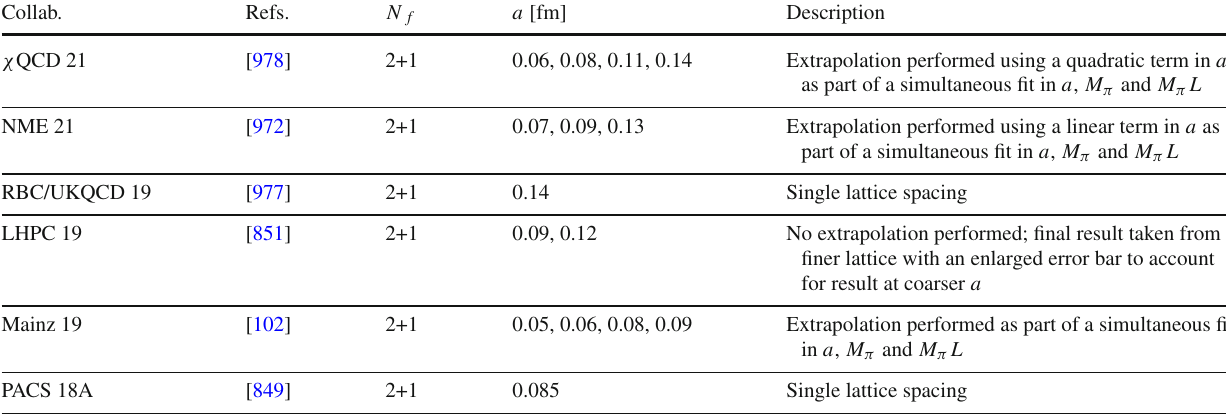
Table175 Continuumextrapolations/estimationoflatticeartifactsindeterminationsoftheisovectoraxial,scalarandtensorchargeswith N f = 2 + 1 quark flavours Collab.